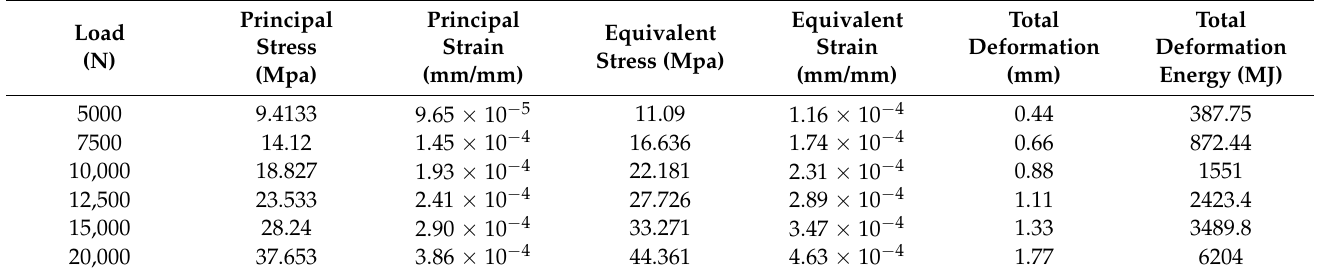
Table A1. Strain and stress isostatic parameters of the deep-sea in situ observatory.